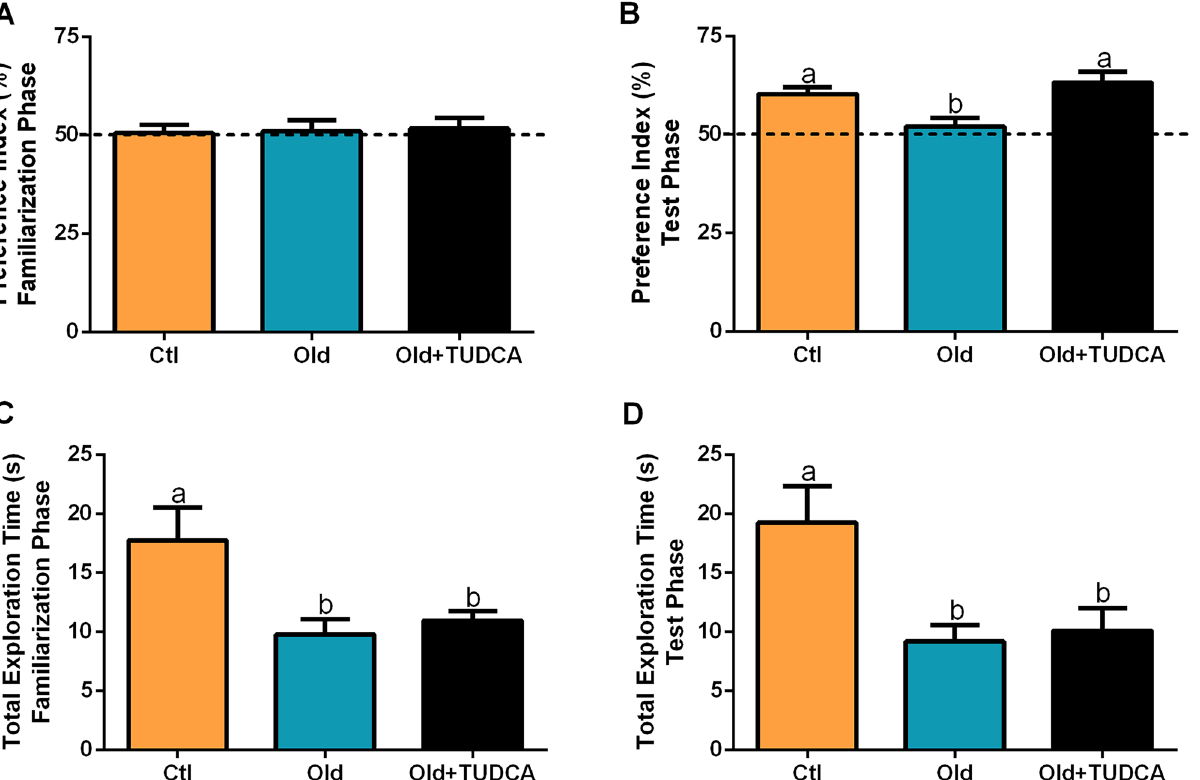
Figure 6. Effects of TUDCA treatment on long-term memory. Preference index (%) during the familiarization ( A ) and test ( B ) phases in the novel object recognition test (NORT). Total exploration time (seconds) during the familiarization ( C ) and test ( D ) phases in the NORT. Data are presented as mean ± SEM (n = 7–10). Statistical analysis was performed using the one-way ANOVA test, followed by Tukey post-hoc-test. Letters shared in common between groups indicate no significant difference. Different letters (a and b) indicate statistical difference between groups (P ≤